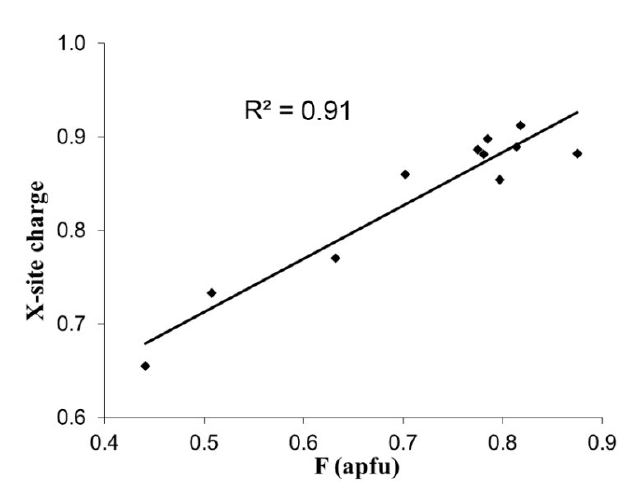
Figure 5. Correlation between the average X-site charge (only Na 1 + , Ca 2 + , K 1 + ) in Cu-bearing tourmalines from the Alto dos Quintos mine, Rio Grande do Norte State, Brazil (samples from [22,27,41,42]).